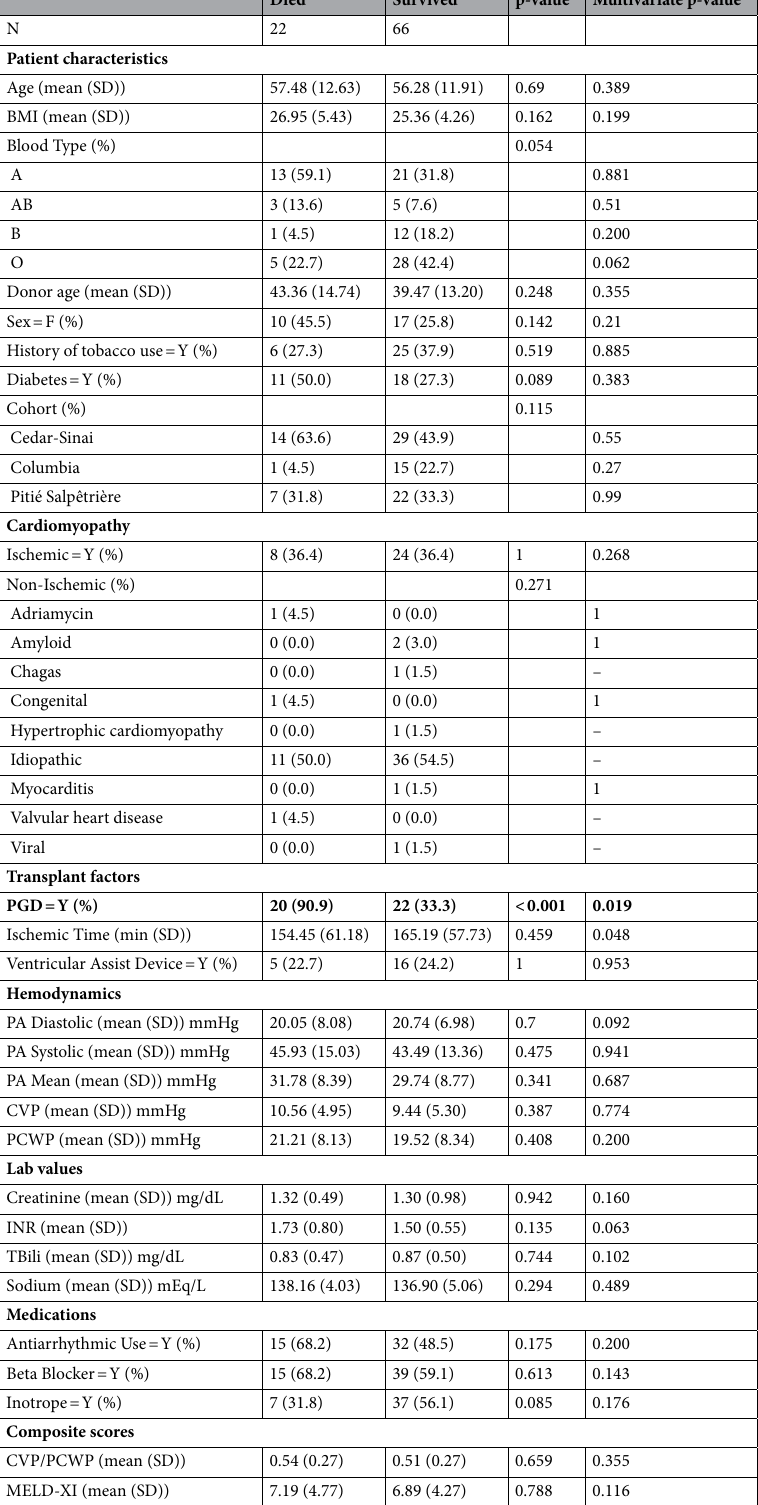
Table 1. Clinical characteristics. Recipient characteristics at the time of transplant unless otherwise specified. Significance evaluated with a continuity-corrected chi-squared test for categorical characteristics and t-test for continuous characteristics. Variables with a dash contributed to a singular matrix when calculating ordinary least squares multivariable regression and were omitted prior to fitting the model. PGD Primary Graft Dysfunction, BMI Body Mass Index, PA Pulmonary Artery, CVP Central Venous Pressure, PCWP Pulmonary Capillary Wedge Pressure, INR International Normalized Ratio, TBili Total Bilirubin, MELD-XI Model for End Stage Liver Disease Score excluding INR. Significant values are in